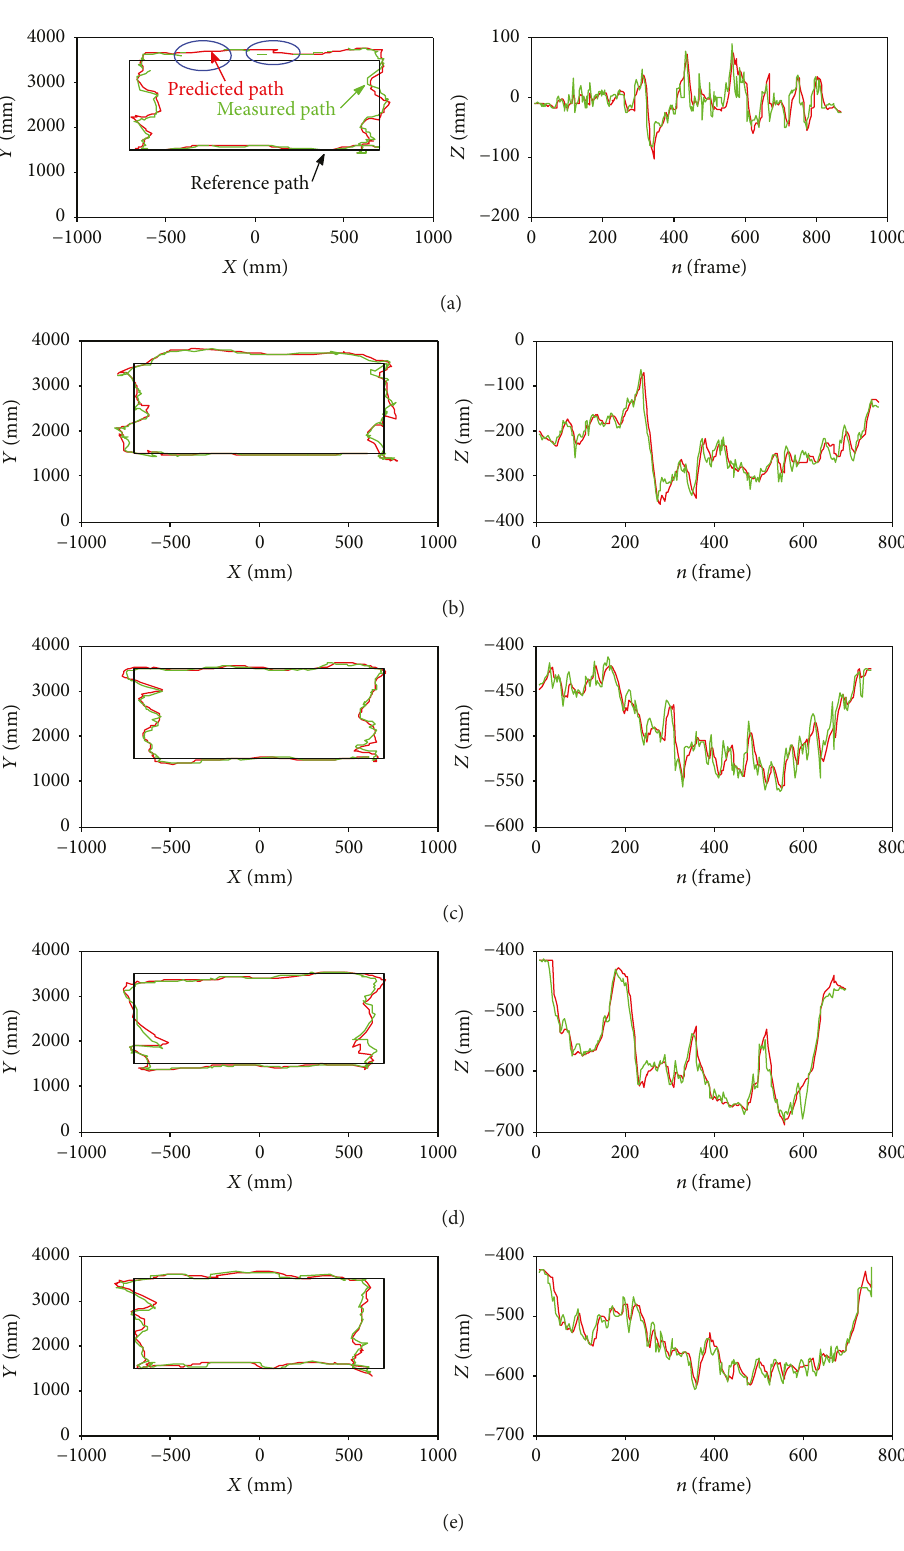
Figure 16: Prediction and measurement results of the tracked subject ’ s spatial in the left pictures represent the 1.4 m × 2 m rectangle refer- indicate the people ’ s moving paths projected to the camera ’ s ence path. Green points represent the measured position XY coordinate plane. The right pictures indicate the people ’ s while red points represent the predicted position. It can be spatial position in the camera ’ s Z coordinate. Black rectangles